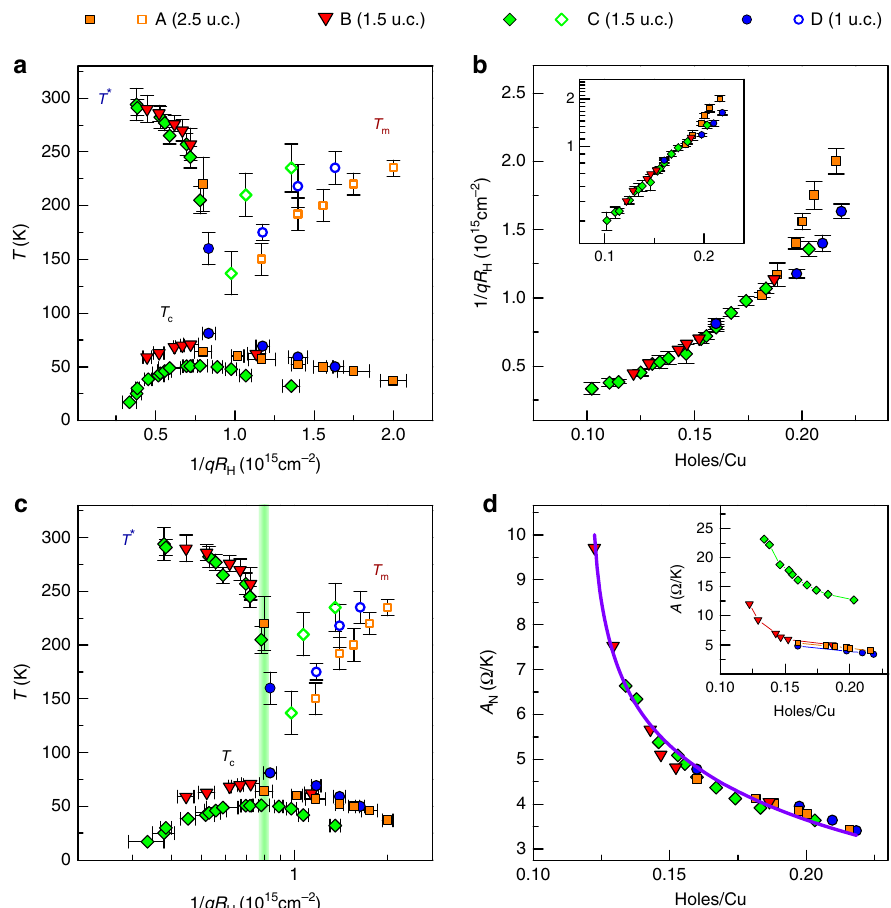
Fig. 4 Phase diagram with carrier density inferred from R H . a Characteristic temperatures as in Fig. 3 with T * ( fi lled symbols), T m (open symbols) and ( fi lled symbols below 100 K) of the four devices as a function of 1/ qR H , and the resulting phase diagram. b Doping calibration: Exponential dependence of 1/ qR H on the calculated holes/Cu. c Same as a but accounting for the exponential functional dependence found in b . The vertical green band indicates the region of optimal doping. Though limitations in the use of R H for estimating doping preclude quantitative conclusions, a qualitative similarity with Fig. 3 can be seen. d Doping dependence of normalized slope A N of the linear part of R S ( T ) in the strange metal phase ( T > T *, T m ). A N values for the four devices fall on a single curve (solid line) given by A N ∝ − b × ln(holes/Cu). Inset: doping dependence of the slope A before normalization. Error bars in a – c take